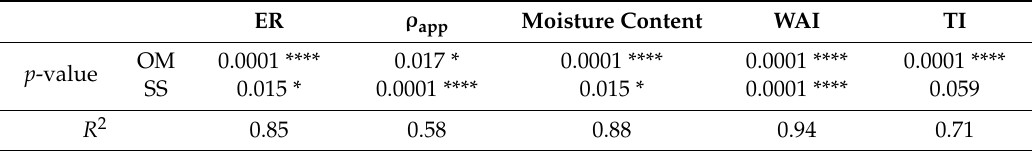
Table 4. Coe ffi cients of factorial regression for the physical properties of the extrudate. ER ρ app Moisture Content WAI TI OM 0.0001 **** 0.017 * 0.0001 **** 0.0001 **** 0.0001 **** p -value SS 0.015 * 0.0001 **** 0.015 * 0.0001 **** 0.059 R 2 0.85 0.58